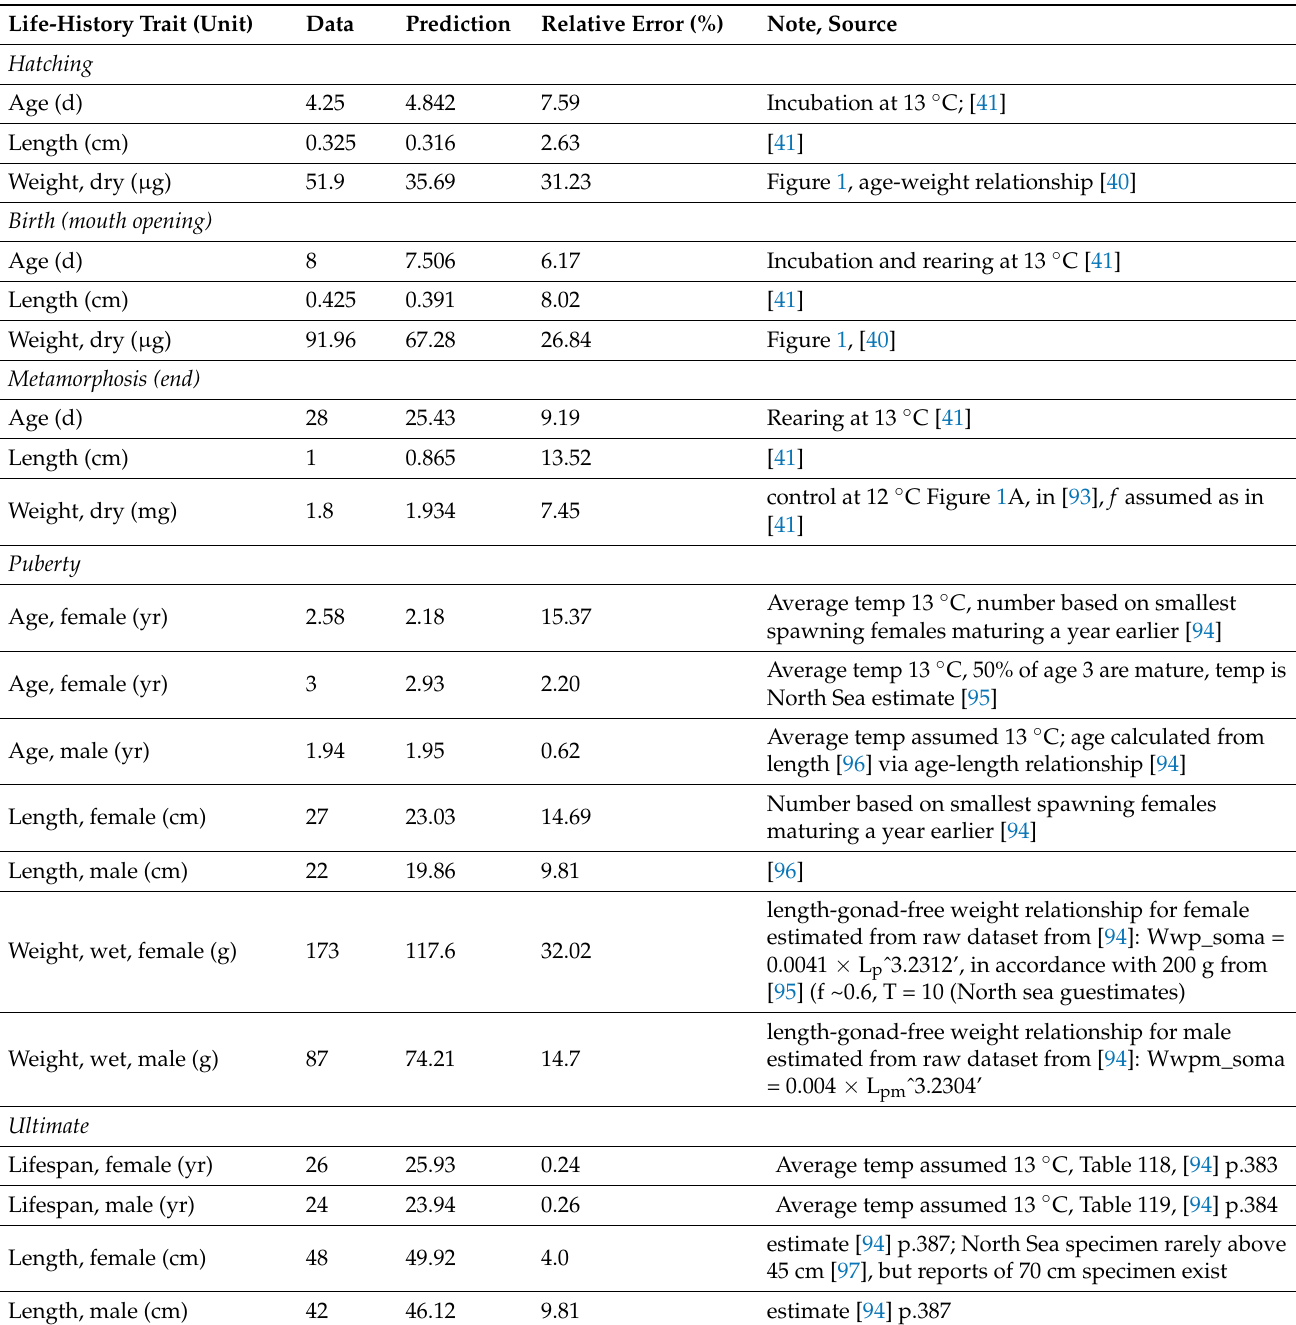
Table A4. Life-history traits (‘zero-variate data’) of common sole ( S. solea ) used for model param- eterization, with corresponding sources, model predictions, and relative errors. Life-history traits are grouped into life stages; ‘Birth’ is defined in DEB as ‘onset of feeding’, and thus corresponds with mouth opening of sole larvae. Definitions of age : ‘Age at hatching’ corresponds to incubation duration (from fertilization until hatching); ‘Age at birth’ corresponds to days needed from fertilization until mouth opening, and ‘Age at metamorphosis’ corresponds to time elapsed between birth (mouth opening) and end of metamorphosis. When relevant, temperatures are listed in the last column under Notes. Unless otherwise specified, the scaled functional response f for certain life-history traits matches that for corresponding datasets: e.g., f for larval age and length data in this Table and sourced from [41] is the same as f for larval growth curves from [41] in Figure S2.1. References for sources (in square brackets) are listed in the general Reference